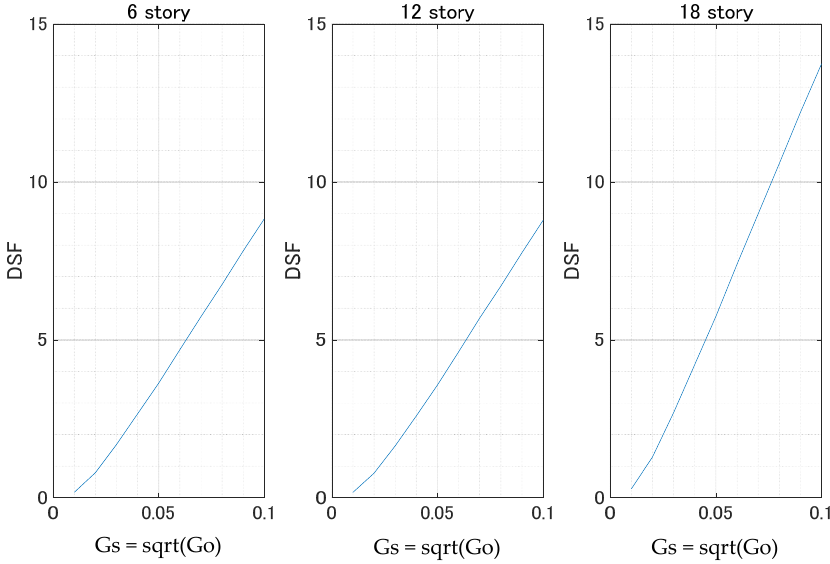
Figure 7. Mean value of damage sensitive features (DSFs, 6th, 12th, and 18th story).